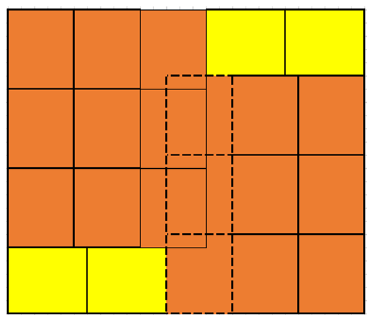
Figure 6. Vertical multi-object overlap.